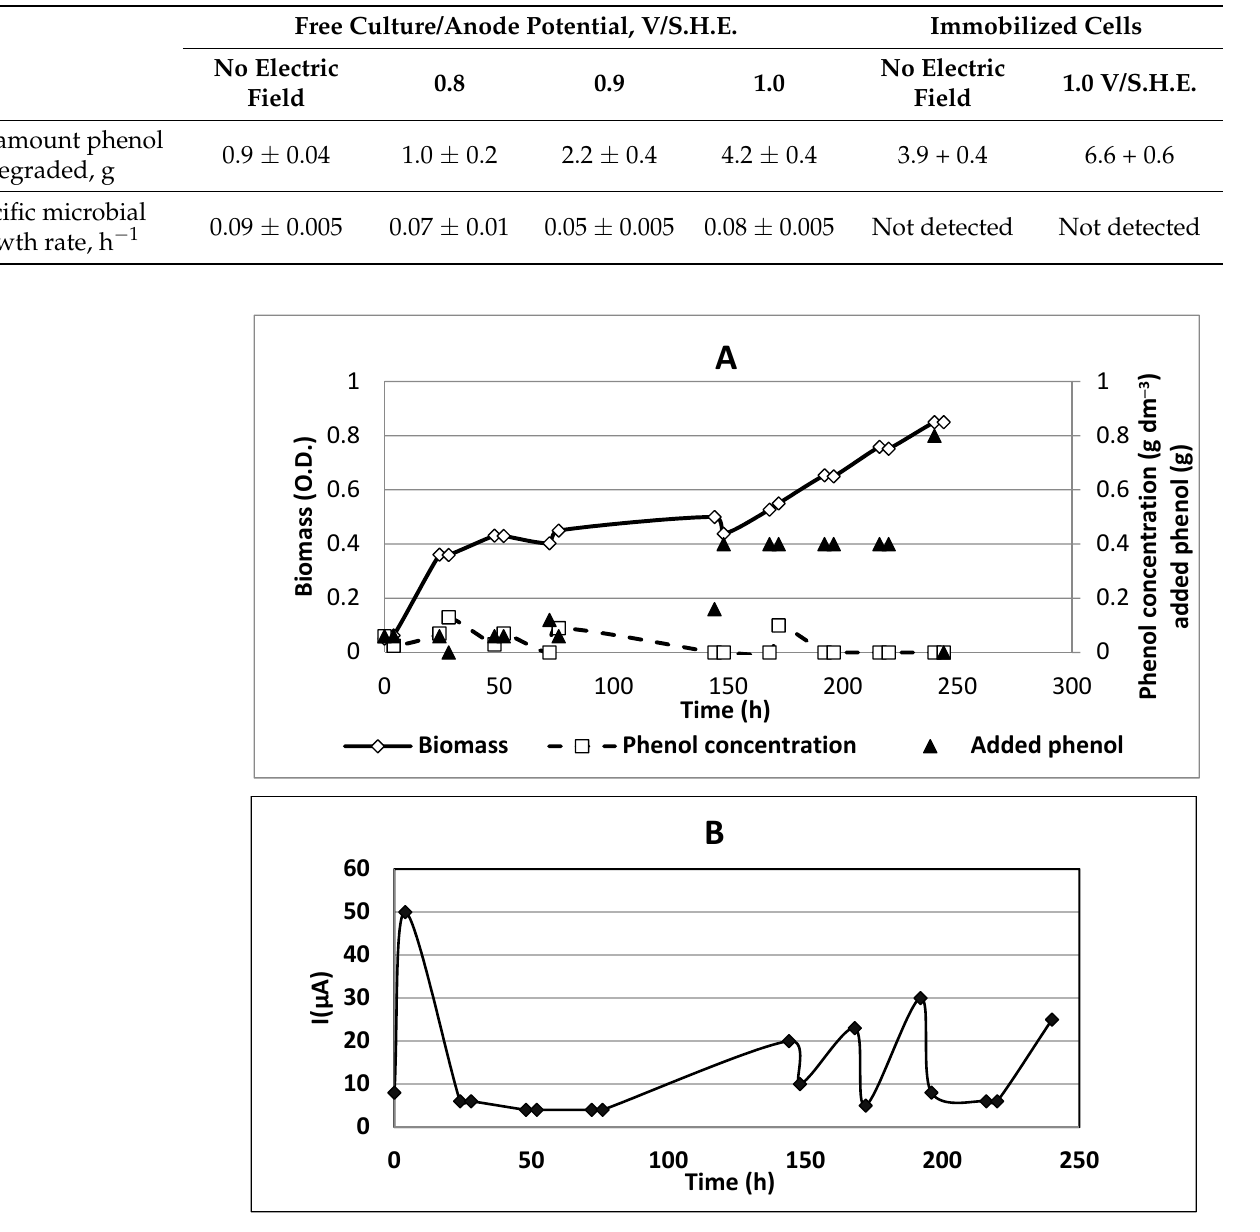
Figure 3. SEM image of free cell samples for SEM analysis: ( A ) control experiment; ( B ) with the constant electric field (0.8 V). 3.4. Effect of Electric Field on Enzyme Activity of Free Cells The experimental results for the enzyme activities with and without application of an electric field in a free cell culture are shown in Table 2. For the control experiments without the application of an electric field, all enzyme activities grew in time. In cases when a constant electric field was applied, the situation became quite interesting. At an anode potential of 0.8 V/S.H.E., the phenol hydrolase was more active at the 144th hour. The catechol-1,2-dioxygenase was more active in the first two samples, whereas at t = 240 h, the control experiment provided better results. The ortho -pathway was predominant for the control experiment. Peculiarly, the catechol-2,3-dioxygenase became very active when the electric field was applied, at 0.8 and 0.9 V/S.H.E. This means that a competitive meta - pathway under these conditions was observed. In the case of anode potential of 1.0 V/S.H.E., the ortho -pathway prevailed, reaching the highest enzyme activity (1.67 U/mg protein) at the end of the process, t = 240 h. At this anode potential, the met a-pathway was not convincing. These results are illustrated in Figure S1. Table 2. Maximum enzyme activities at different anode potentials. Initial phenol concentration, 0.06 g dm −3. Anode Potential, V/S.H.E